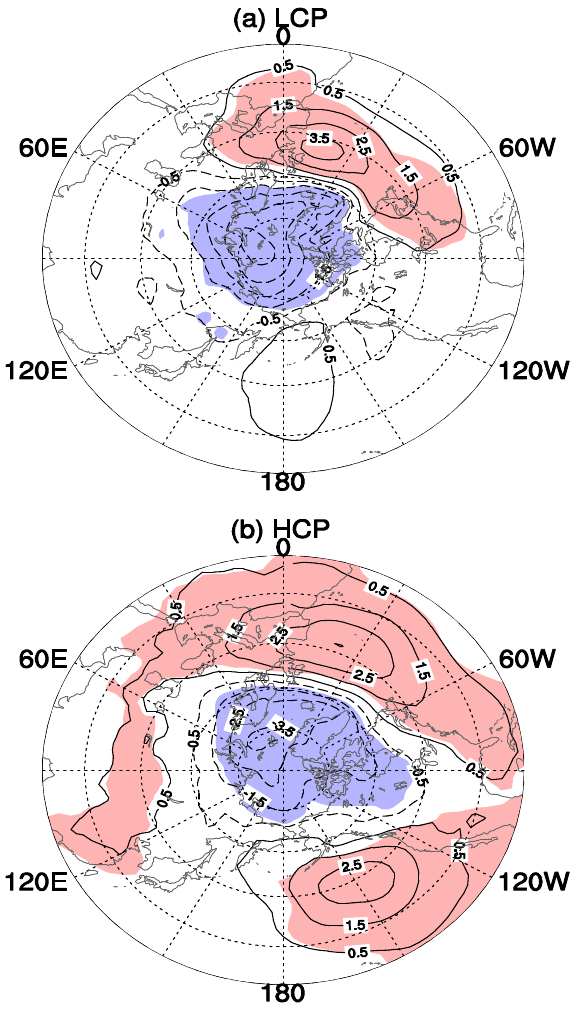
Figure 7. Winter SLP anomalies (hPa) regressed upon the standardized winter AO index during ( a ) 1972–1987 and ( b ) 1997–2012. Shaded regions denote SLP anomalies significant at the 5%